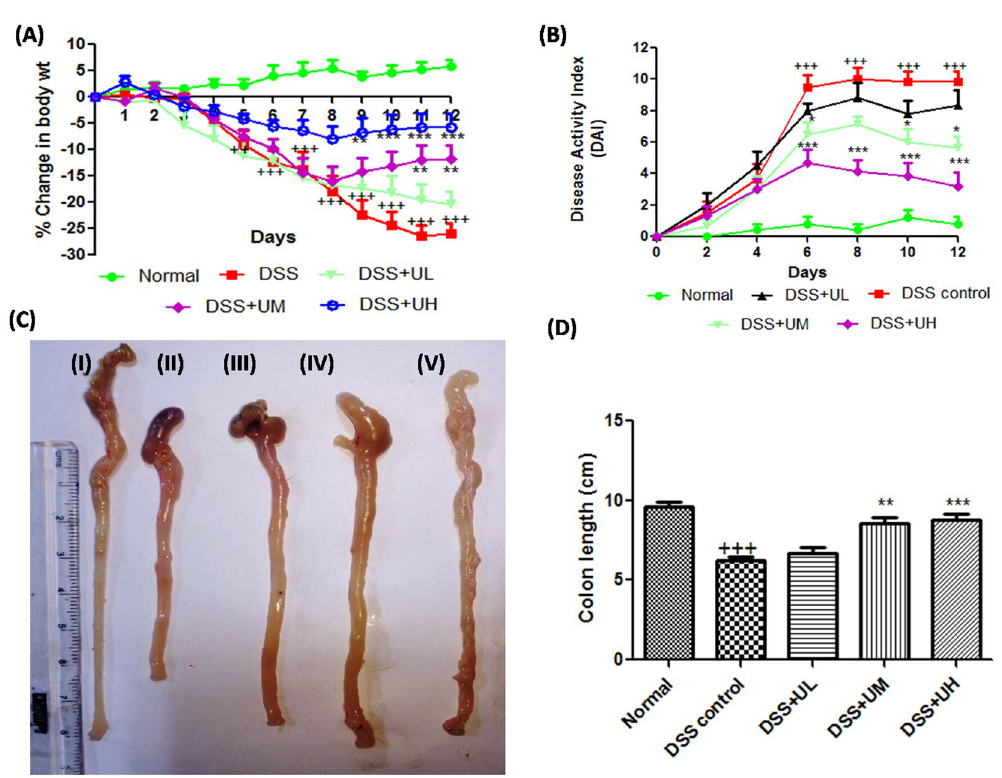
Figure 3. Effect of uridine treatment on the clinical signs of colitis and macroscopic signs of inflammation in colon tissue. Experimental colitis was induced by 3.5% w/v of DSS in drinking water ( ad libidum) for 5 days. ( A ) Percentage change in body weight. ( B ) Disease activity index, a composite measure of weight loss, stool consistency and blood in stool. ( C ) Representative photographs showing colon tissue from I, Normal; II, DSS control; III, DSS + UL; IV, DSS + UM; V, DSS + UH ( D ) Changes in colon length. Data presented indicate the mean ± SEM (n = 6). +++ p < 0.001 vs Normal, * p < 0.05, ** p < 0.01 and *** p < 0.001 vs DSS